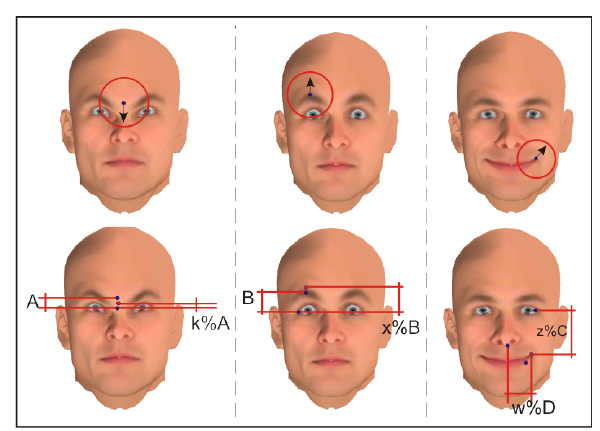
Figure 15. Example of aplication of deformations and storage of measures proportions.